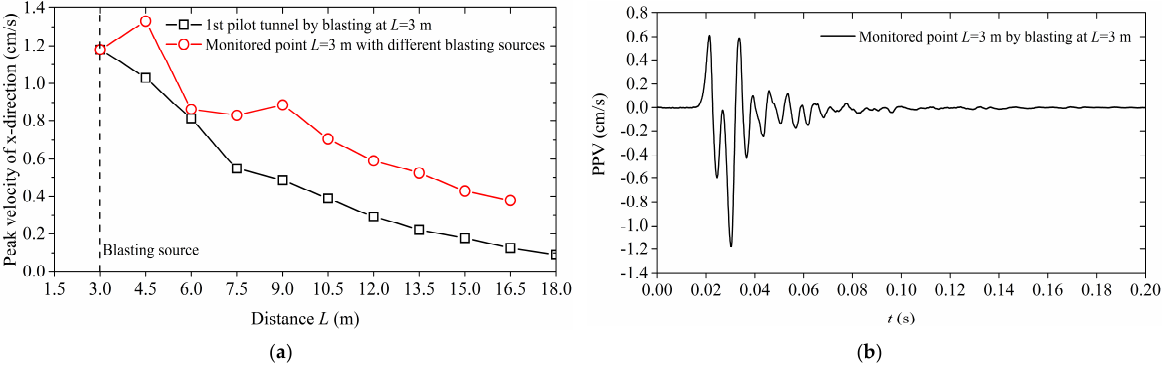
Figure 11. Dynamic responses of the 1st pilot tunnel induced by blasting the 4th pilot tunnel: ( a ) Peak velocity of z-direction; ( b ) PPV of monitored point L = 3 m.